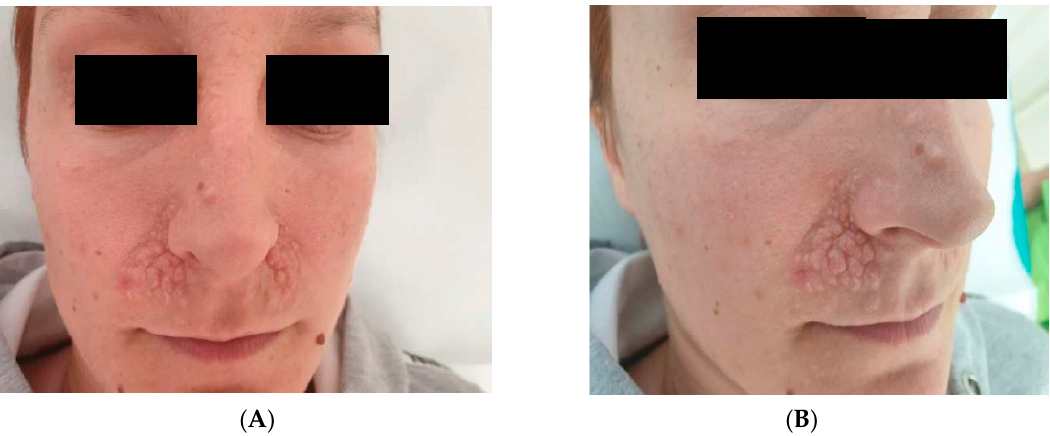
Figure 1. ( A , B ) Multiple facial trichoepitheliomas localized predominantly on the nasolabial folds, with a symmetrical distribution.